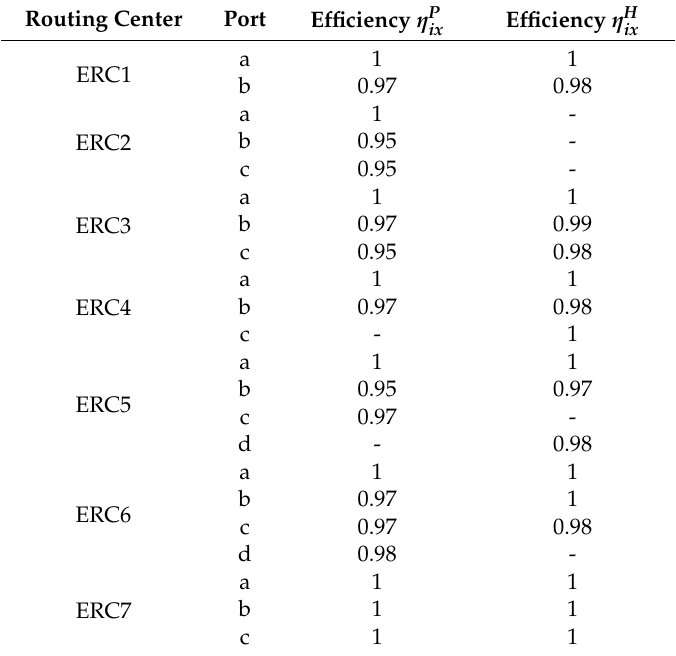
Table 3. Electric conversion efficiency of each energy routing port.